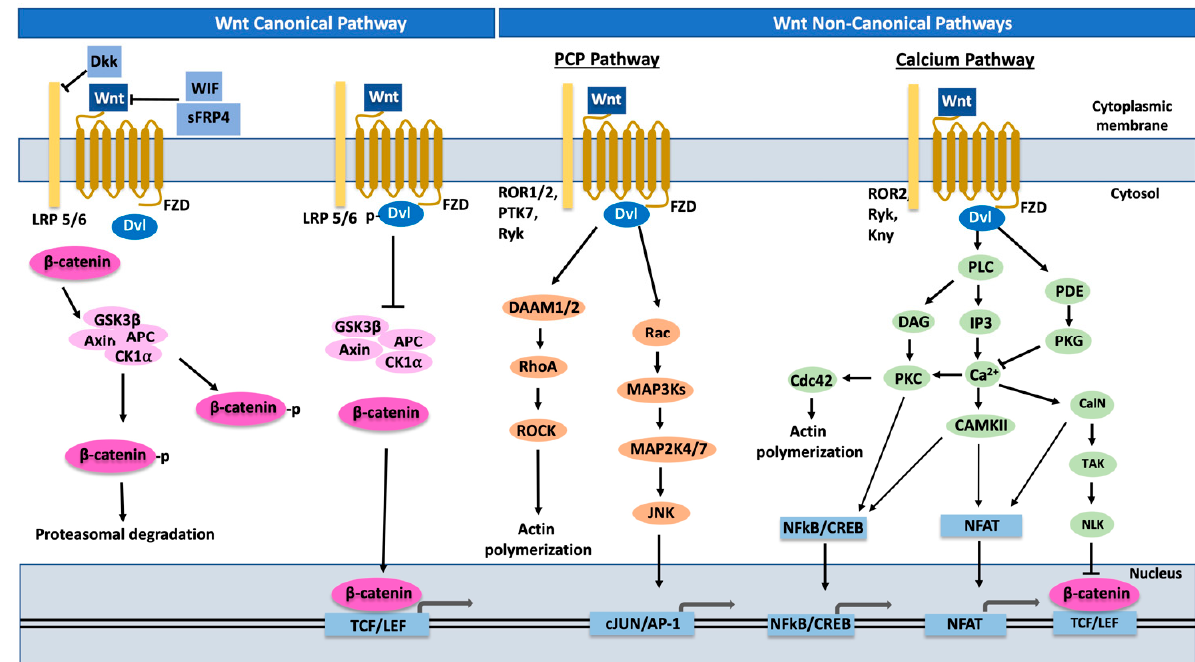
Figure 2. Wnt signaling pathways. Wnt canonical ( β -catenin dependent) and Wnt non-canonical (Planar cell polarity and Calcium) pathways. AP-1, Activation protein 1; APC, Adenomatosis polyposis coli; Ca 2+ , Calcium; CalN, Calcineurin; CAMKII, Calcium-calmodulin-dependent kinase II; Cdc42, Cell division control protein 42 homolog; CK1 α , Casein kinase 1 alpha; CREB, cAMP response element-binding protein; DAAM1/2, Disheveled-associated activator of morphogenesis 1/2; DAG, Diacylglycerol; Dkk, Dickkopf; Dvl, Disheveled; FZD, Frizzled; GSK3 β , Glycogen synthase kinase 3 β ; IP3, Inositol 1,4,5-triphosphate; JNK, c-Jun N-terminal kinase; LEF, Lymphoid enhancer-binding factors; LRP 5/6, Low-density lipoprotein receptor-related protein 5 or 6; MAP2K 4/7, Mitogen- activated protein kinase kinase 4/7; MAP3Ks, Mitogen-activated protein kinase kinase kinase; NFAT, Nuclear factor of activated T cells; NF κ B, Nuclear factor kappa light chain enhancer of activated B cells; NLK, Nemo-like kinase; PDE, Phosphodiesterase; PKC, Protein kinase C; PKG, Protein kinase G; PLC, Phospholipase C; Rac, Ras-related C3 botulinum toxin substrate; RhoA, Ras homolog family member A; ROCK, Rho Kinase; ROR2, RAR-related orphan receptor 2; Ryk, receptor-like tyrosine kinase; sFRP, Secreted frizzled related protein; TCF, Transcription factors T cell factor; WIF, Wnt inhibitory factor; Wnt, Wingless-type MMTV integration